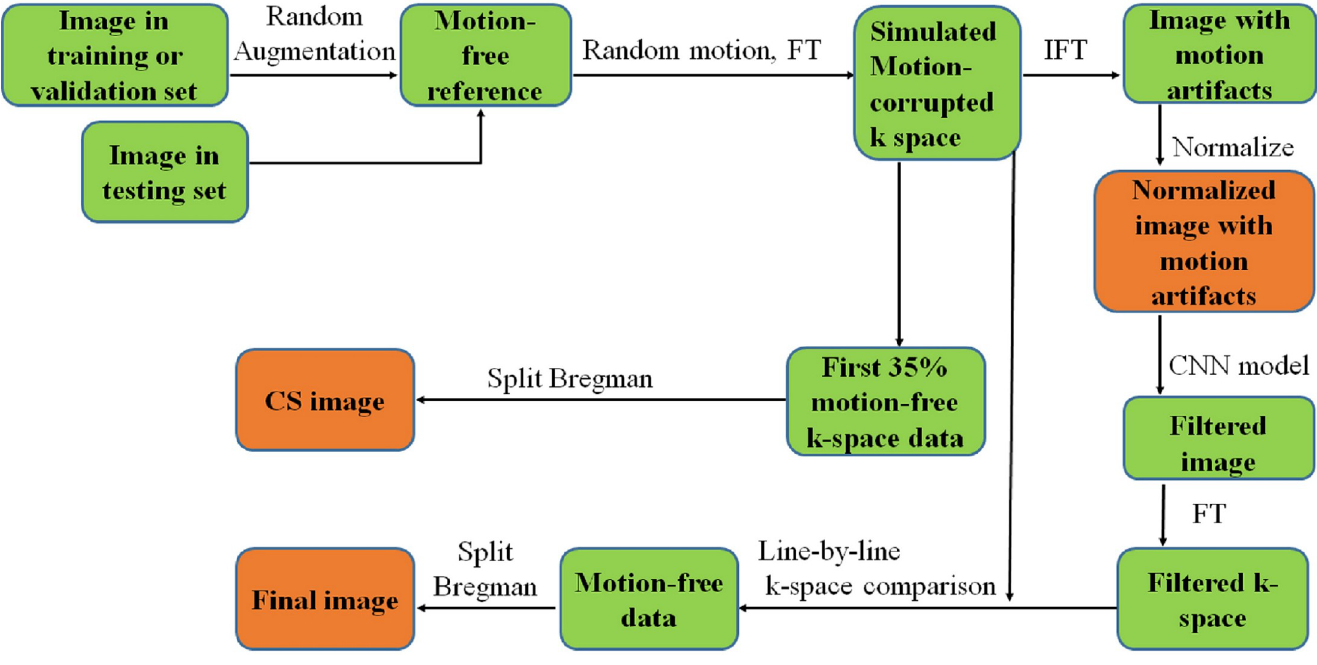
Fig 1. The flowchart of the proposed